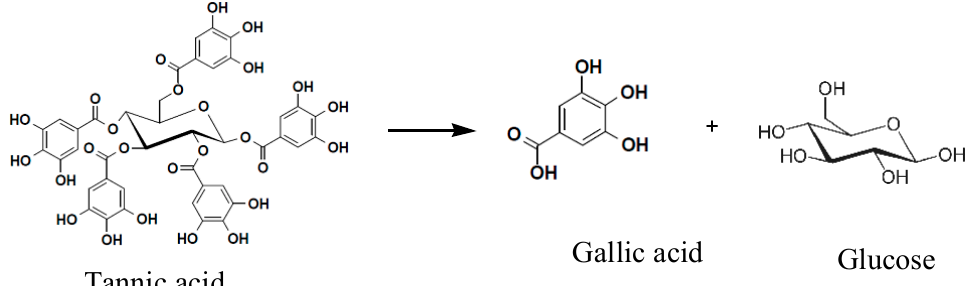
Figure 2. HPLC of a standard gallic acid sample and fermented gallnut water extract (FGWE), ( a ) standard sample of gallic acid; ( b ) the fermentation broth of GWE. The degradation rate of GWE tannic acid exceeded 85.6%. The concentration of gallic acid